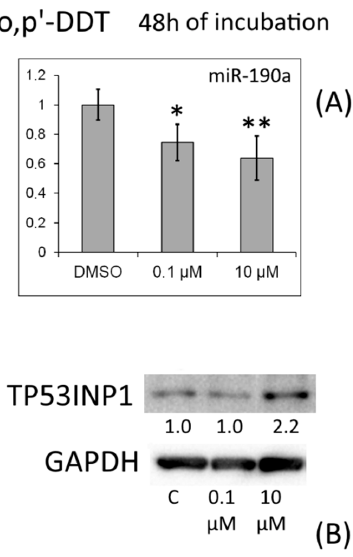
14 of 21 Figure 6. ( A ) Relative levels of TP53INP1 mRNA and of miRNAs targeting it (miR-193b and miR-342) in MCF-7 cells exposed to o,p ′ -DDT. The Y-axis shows the ratio of the mRNA or miRNA amount in the cells treated with a DDT isomer to the mRNA or miRNA amount in the cells treated with DMSO. Each value is the mean of three independent experiments. * Significant differences from the control ( p < 0.05). ( B ) Western blot analysis of TP53INP1 in cells incubated with o,p ′ -DDT.